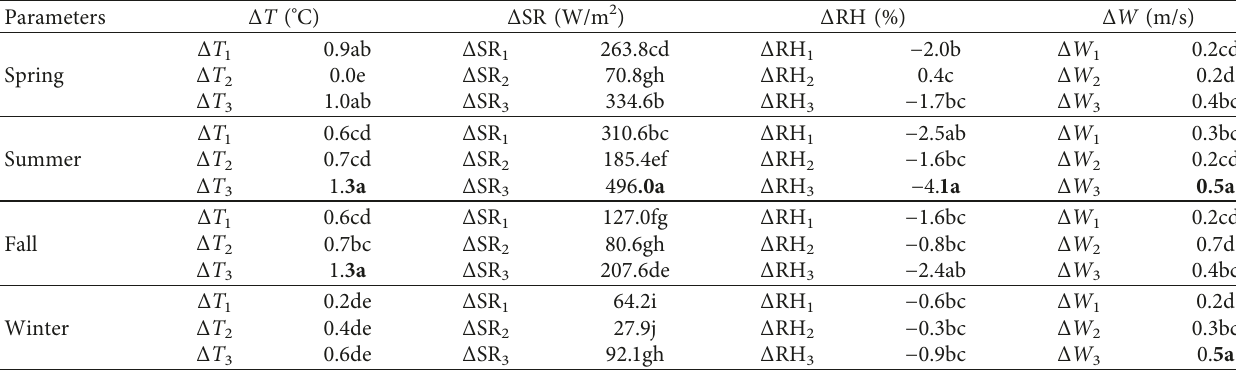
Table 4: Seasonal differences in the micrometeorology parameters.